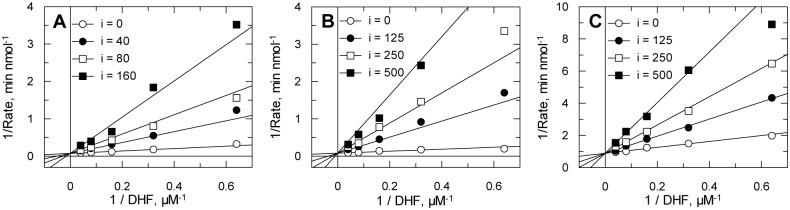
Modality of inhibition of antifolate drugs against DHFR activity.(A) pyrimethamine, (B) trimethoprim and (C) raltitrexed. Recombinant TbDHFR-TS was assayed in the presence of varying concentrations of substrate (DHF) and fixed amounts of inhibitor (see legends for concentrations in nM). Each double reciprocal plot was inspected for inhibition pattern and then globally fitted by non-linear regression to equations describing either competitive or mixed inhibition. Statistical F-tests using GraFit revealed that competitive inhibition gave the best fit in all cases.